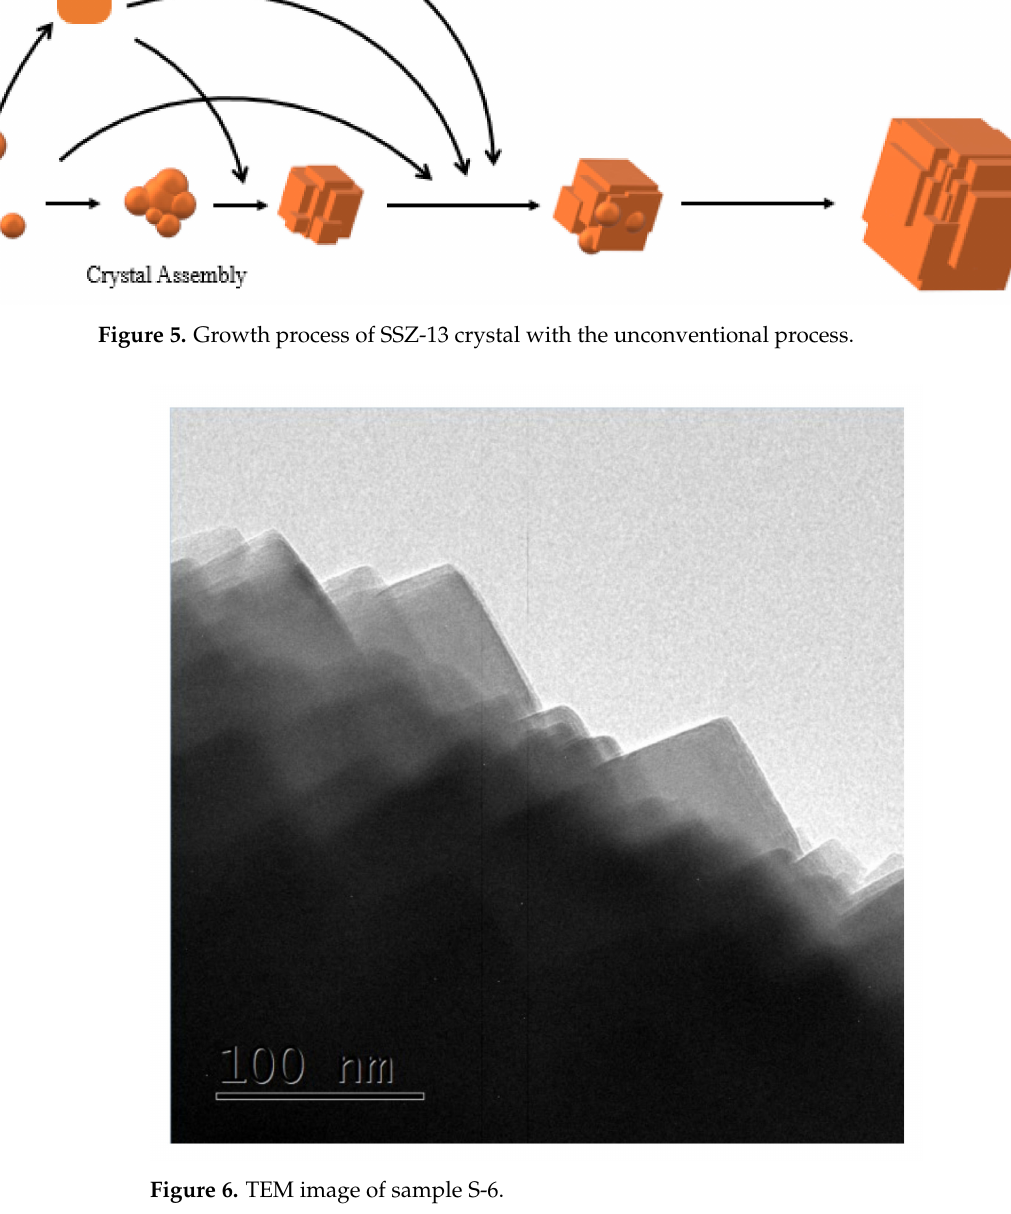
Figure 6. TEM image of sample